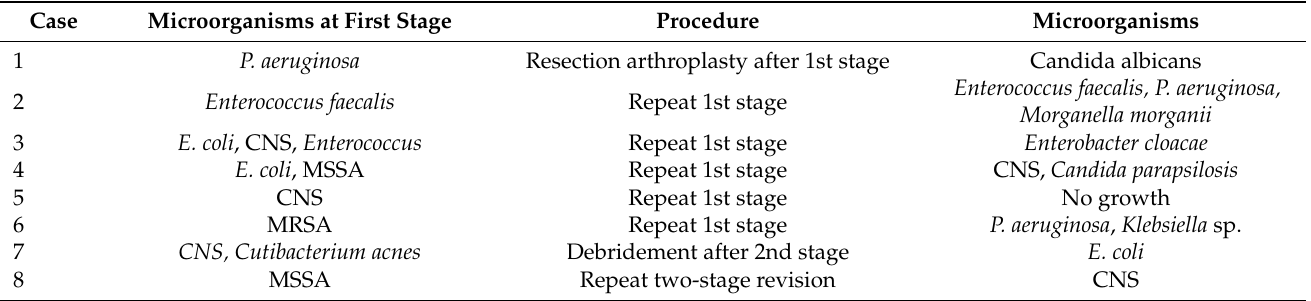
Table 4. Microorganisms identified in the cases with possible persistent infection after first surgery, first-stage revision, or reinfection after multi-staged